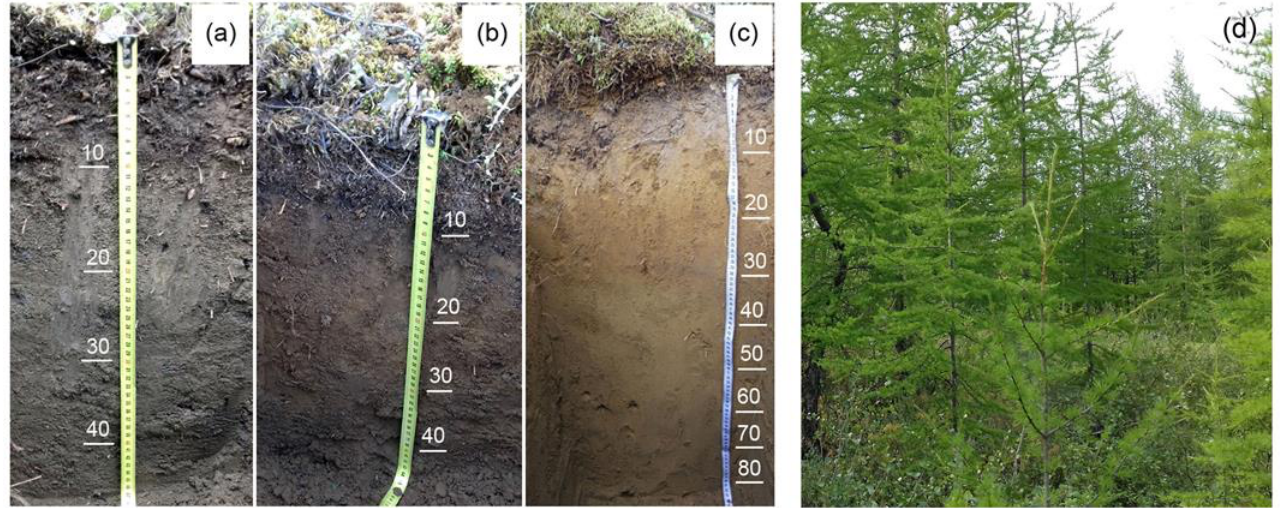
Figure 2. Soil profiles of the dominant types of Cryosols in the The Khannya–Nakyn interfluve (photo by V. Boeskorov, A. Gololobova; date of photo: 16.08.2018): ( a ) Turbic Cryosols (Reductaquic), P-33-Н, N 65°00'33.1", E 117°05'35.0"; ( b ) Turbic Gleyic Cryosols (Reductaquic), P-28-H, N 64°59'51.5", E 117°05'03.2"; ( c ) Turbic Gleyic Natric Cryosols (Reductaquic), P-34-H, N 65°01'48.6", E 117°05'20.1"; ( d ) Larch-tree with birch, ledum-blueberry .